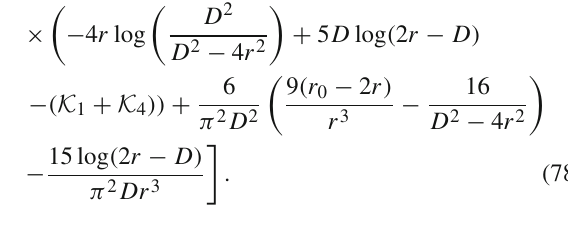
At throat, the above expressions for NEC reduces